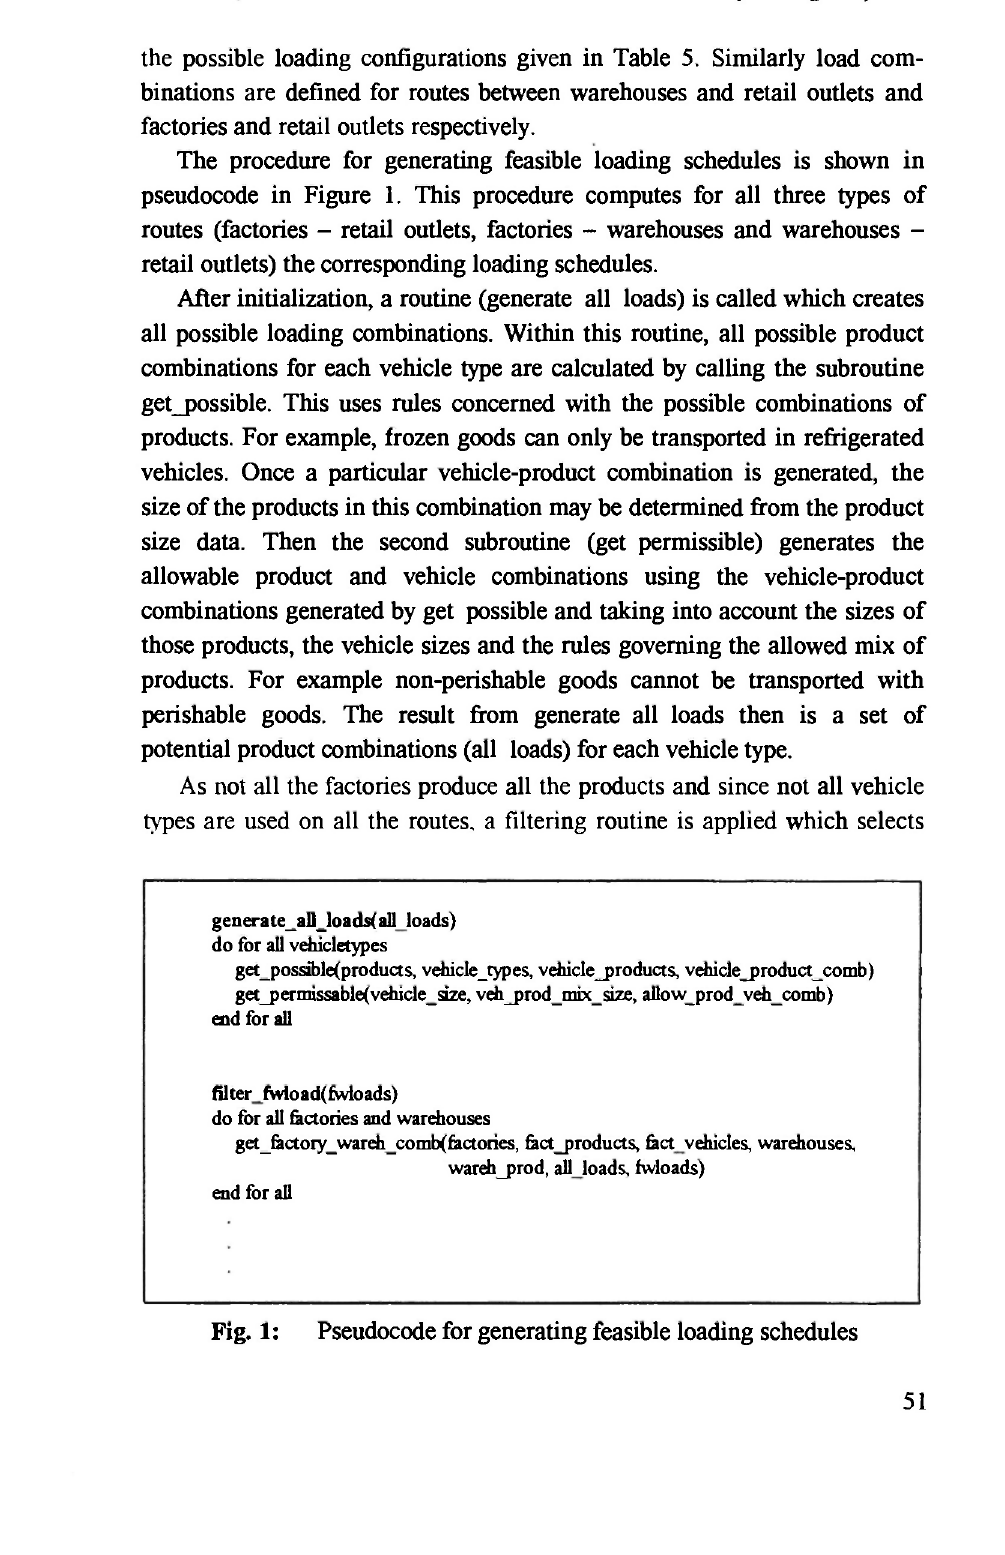
Fig. 1: Pseudocode for generating feasible loading